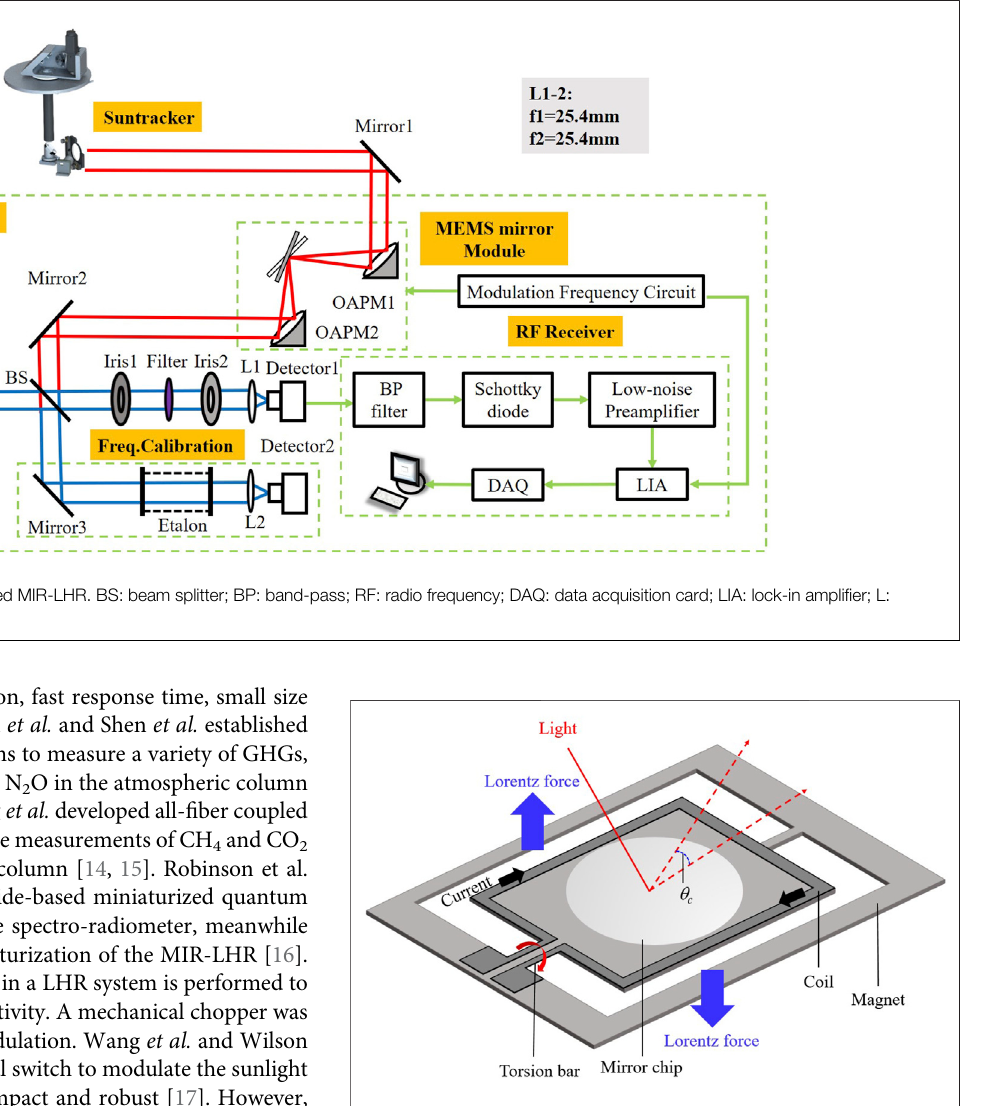
FIGURE 2 | Operation principle of the MEMS